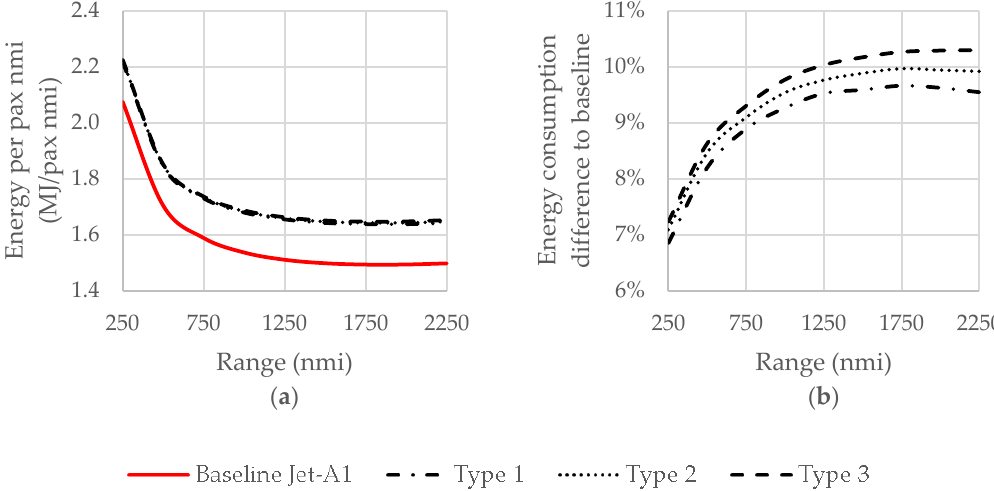
Figure 11. ( a ) Energy per pax nmi against range and ( b ) corresponding difference from the baseline.